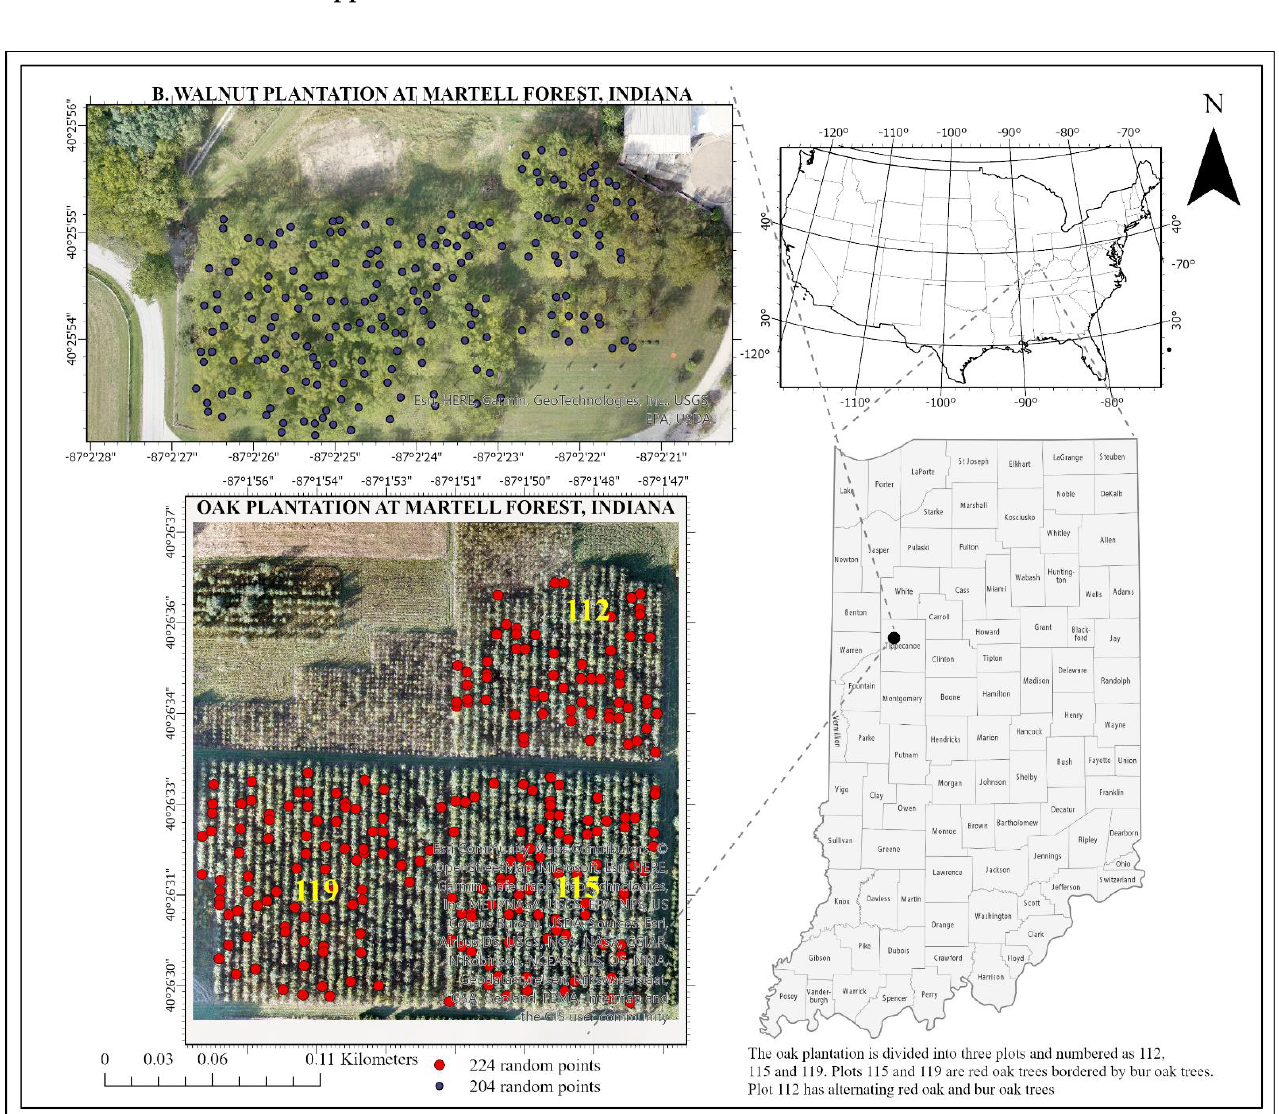
Figure A1. Location map of the two plantation areas. Top: black walnut; bottom: red oak; located in Indiana, USA. Table A2. Pix4D processing workflow settings for the datasets.